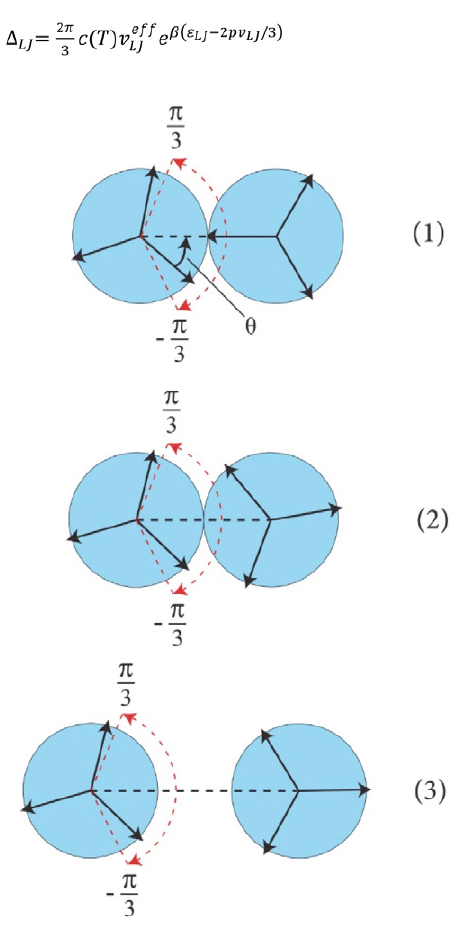
Figure 4: The three model states: (1) hydrogen bonded, (2) vdW bonded, and (3) nonbonded in 2D.